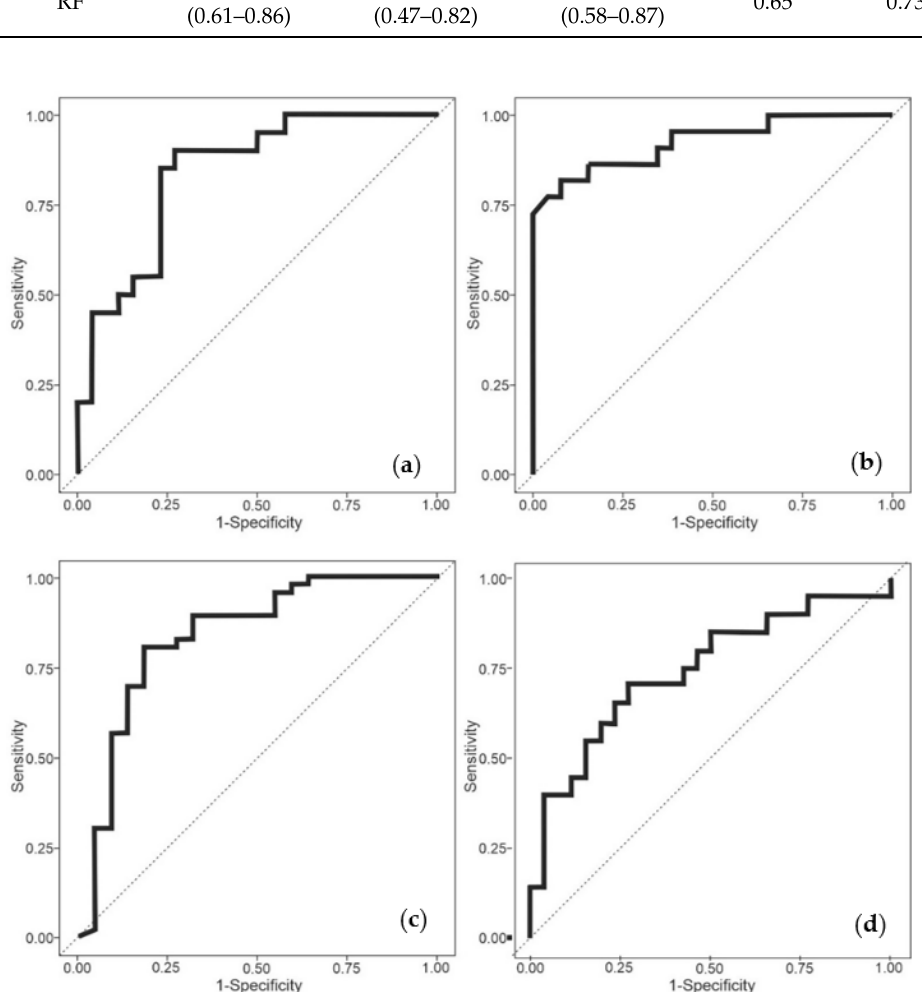
Figure 5. ROCs for patient groups combinations ( a ) Covid-19 positive vs. Control ( b ) Symptomatic vs. Control, ( c ) Asymptomatic vs. Control and ( d ) Symptomatic vs. Asymptomatic. Table 3. Statistical results comparing different patient groups using individual chemicals.